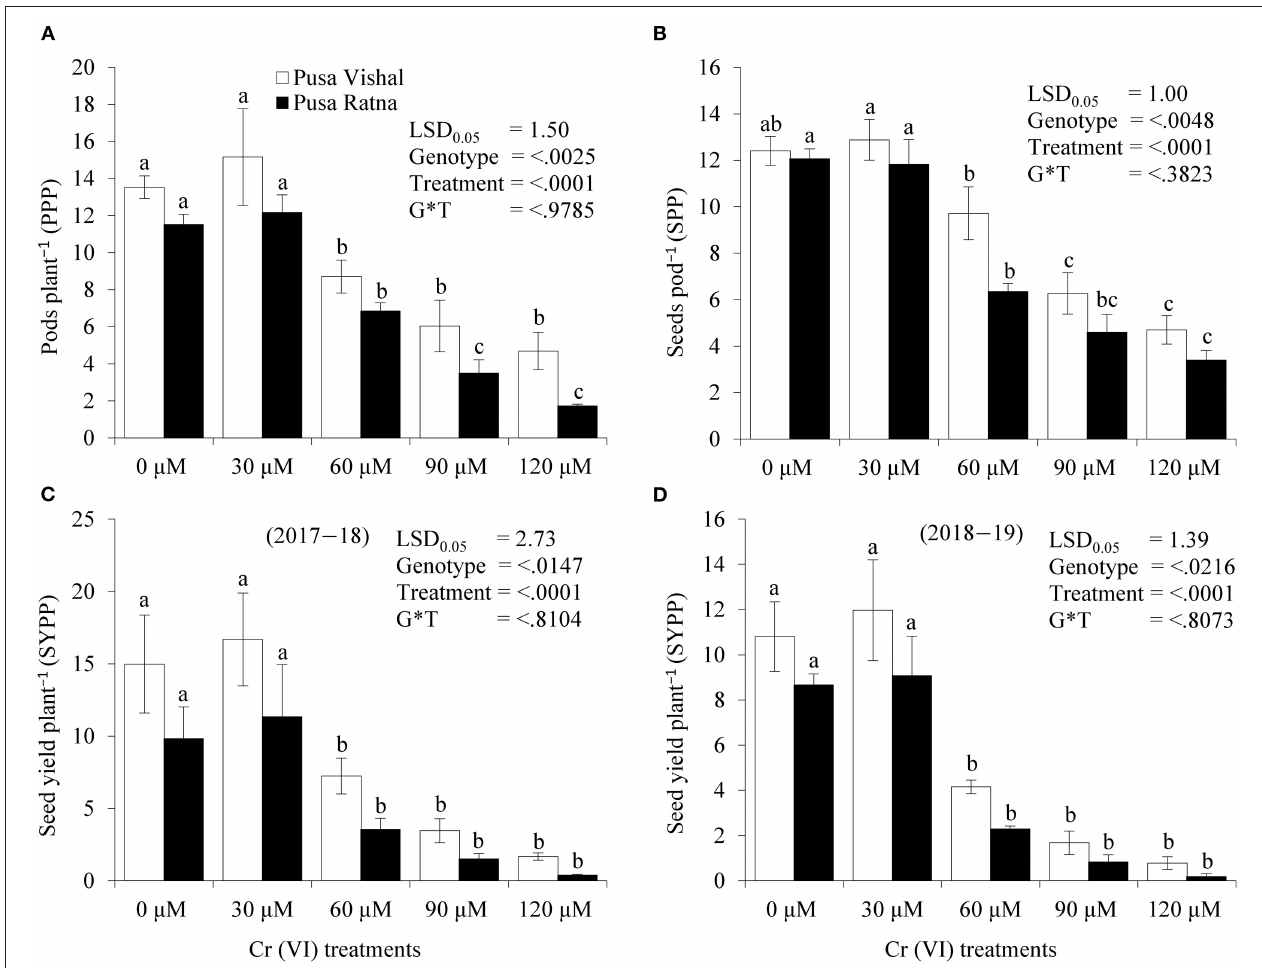
FIGURE 8 | Effect of different chromium (Cr [VI]) treatments on yield attributes:— (A) Pods per plant, (B) Seeds per pods, (C) Seed yield per plant (2017–2018), and (D) Seed yield per plant (2018–2019) in two Mungbean cultivars, Pusa Vishal (PV) and Pusa Ratna (PR), grown in pot conditions. Mean values of three replicates are shown; error bar ( ± standard error [SE]). Mean values with the same letter don’t have significant difference at p ≤ 0.05 according to the Least Significant Difference test (LSD 0.05